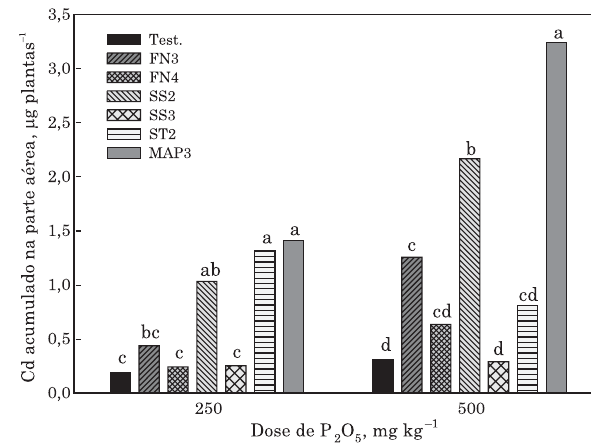
Figura 2. Quantidade de Cd acumulado na parte aérea da aveia preta pela adição de fertilizantes fosfatados a um Nitossolo Vermelho distroférrico latossólico. Médias seguidas por mesma letra na dose não diferem pelo teste de Tukey a